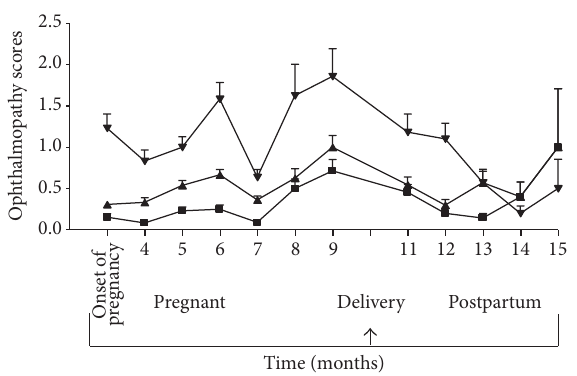
Figure 1: Eye changes, assessed as mean ( ± ) Clinical Activity Score (0–12) ( ◼ ), NOSPECS classes (1–7) ( 󳵳 ), and upper eyelid retraction score (0–12) ( 󳶃 ) in pregnant women with Graves hyperthyroidism and Hashimoto thyroiditis considered as a single group (thyroid autoimmunity), before, during, and following